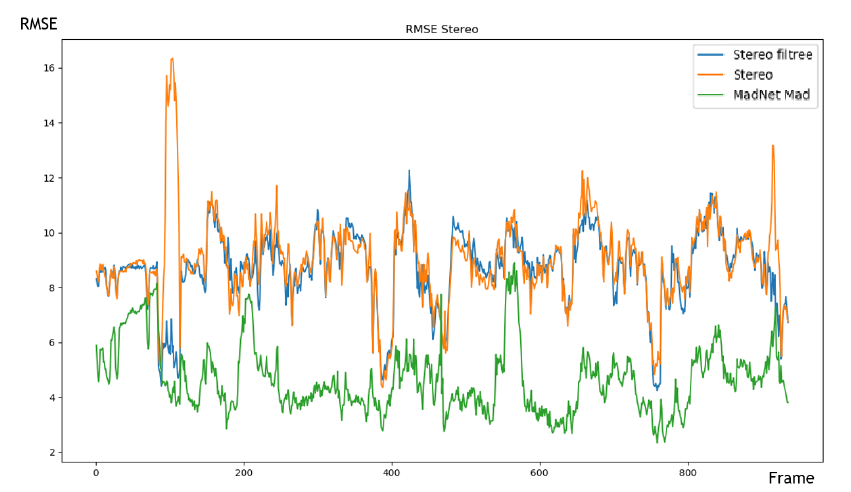
Figure 8. RMSE error over a sequence of around 900 frames from the KITTI dataset. The blue, orange and green curves correspond respectively to the results of Stereo-WLS Filter, Stereo-baseline and MADNet approaches.